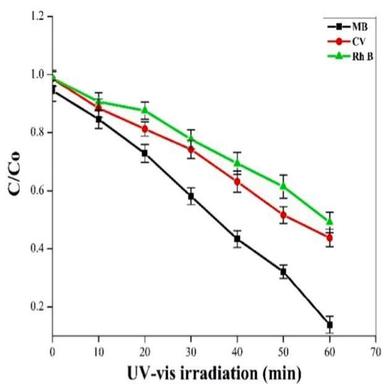
Photocatalytic Degradation Efficiency (C/Co) plot of Different Dye Pollutants.